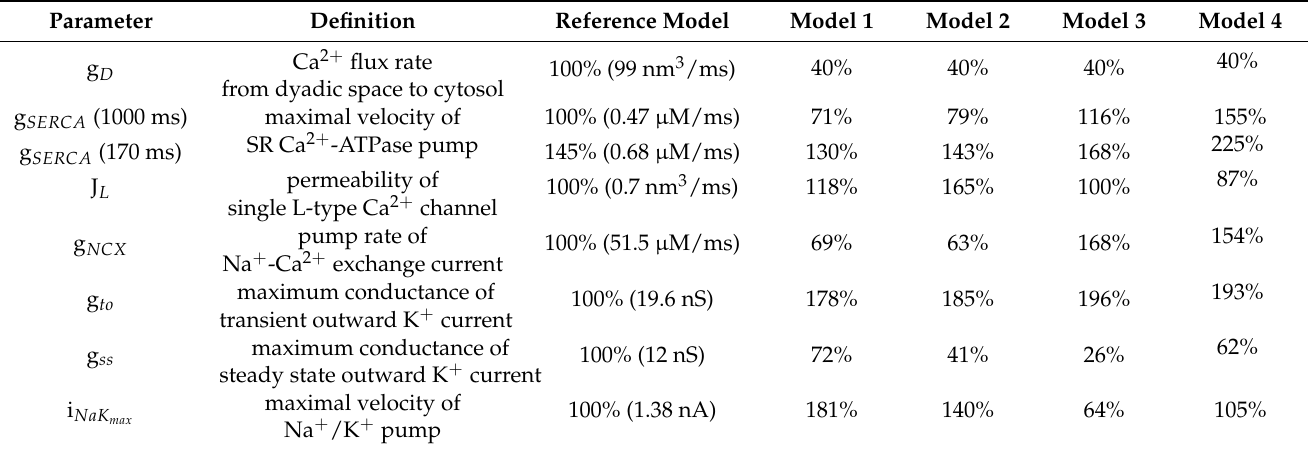
Table 1. Parameter values in four selected model samples as a percentage of the reference values at a basic cycle length of 1000 ms from the Gattoni 2016 model